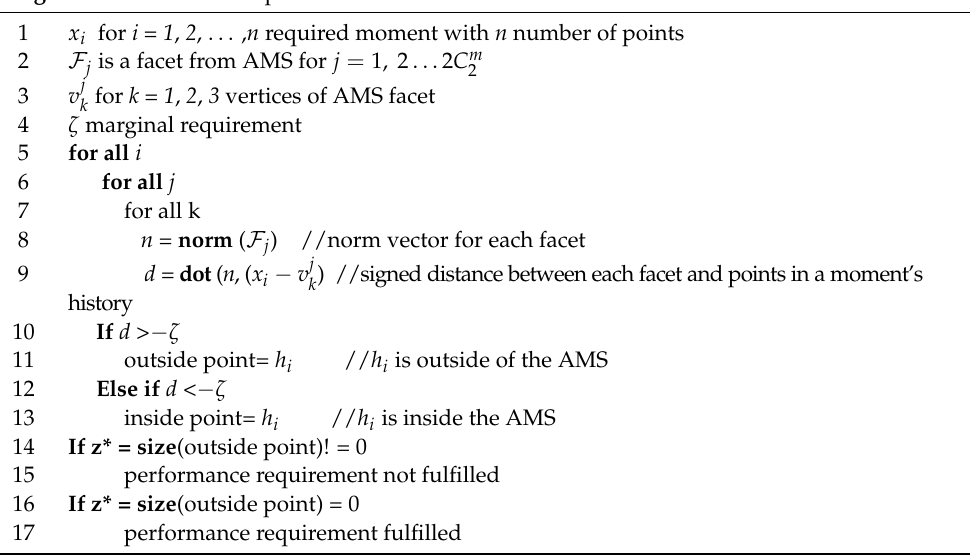
Algorithm 1 Inside-AMS-point check